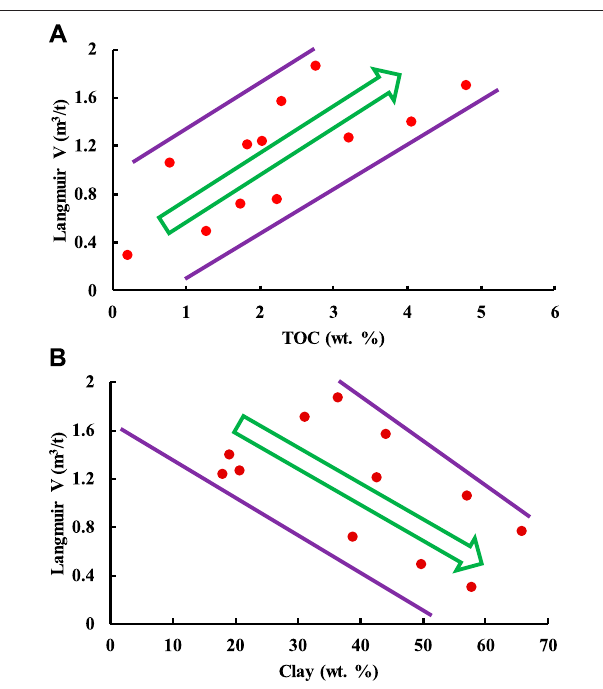
FIGURE 2 | Analysis of Langmuir Volume ’ s relation with TOC content and clay mineral content. The graph shows Langmuir Volume has a positive correlation with TOC content and a negative correlation with clay mineral content.